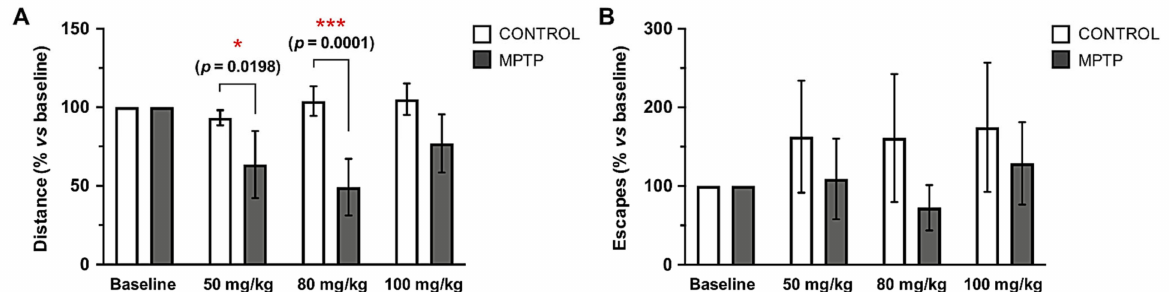
Figure 2. Traveled distance and escapes in the open field test decrease in the O. degus intoxicated with MPTP. Motor condition was evaluated by the actimeter test at four time points, taking the cumulative dose of MPTP as reference: before the MPTP injections started (baseline), 50 mg/kg, 80 mg/kg and 100 mg/kg. ( A ) Distance travelled by the animals expressed as a percentage in relation to its own baseline data. ( B ) Number of escapes from the arena of the open-field expressed as a percentage in relation to its own baseline data. Data are expressed as mean ± SD; * p < 0.05; *** p <